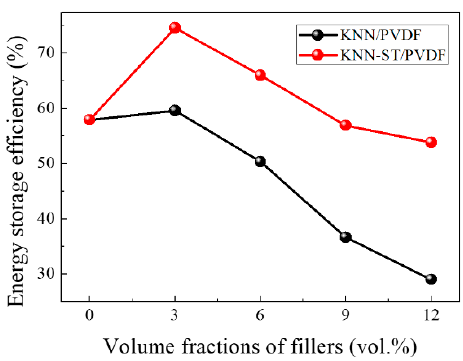
Figure 9. Energy storage efficiency of KNN/PVDF and KNN-ST/PVDF composites films.